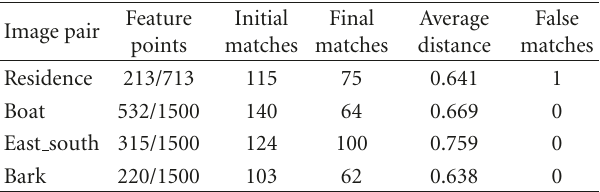
Table 1: Matching results for Figures